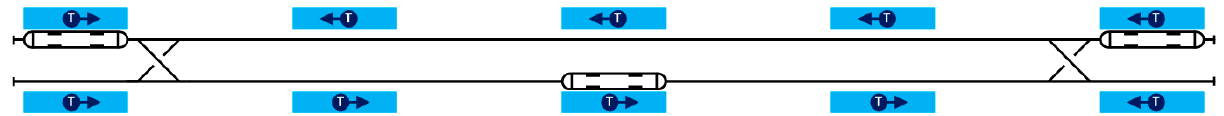
Figure 3. Operation of a bi-directional tram on a route with switch-back terminals at both ends of the tram route.